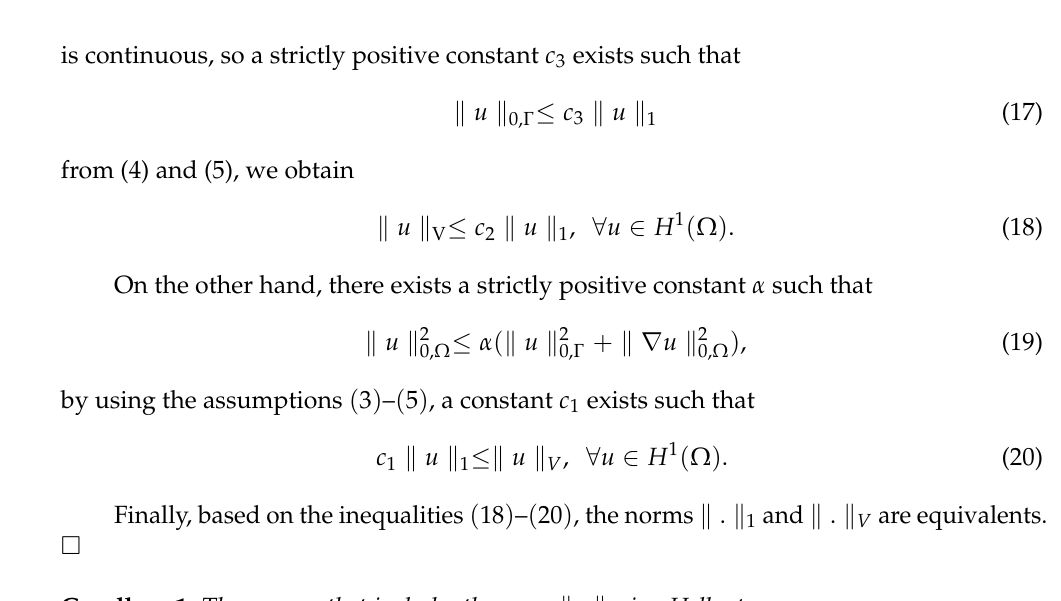
Figure 2. Mini-element